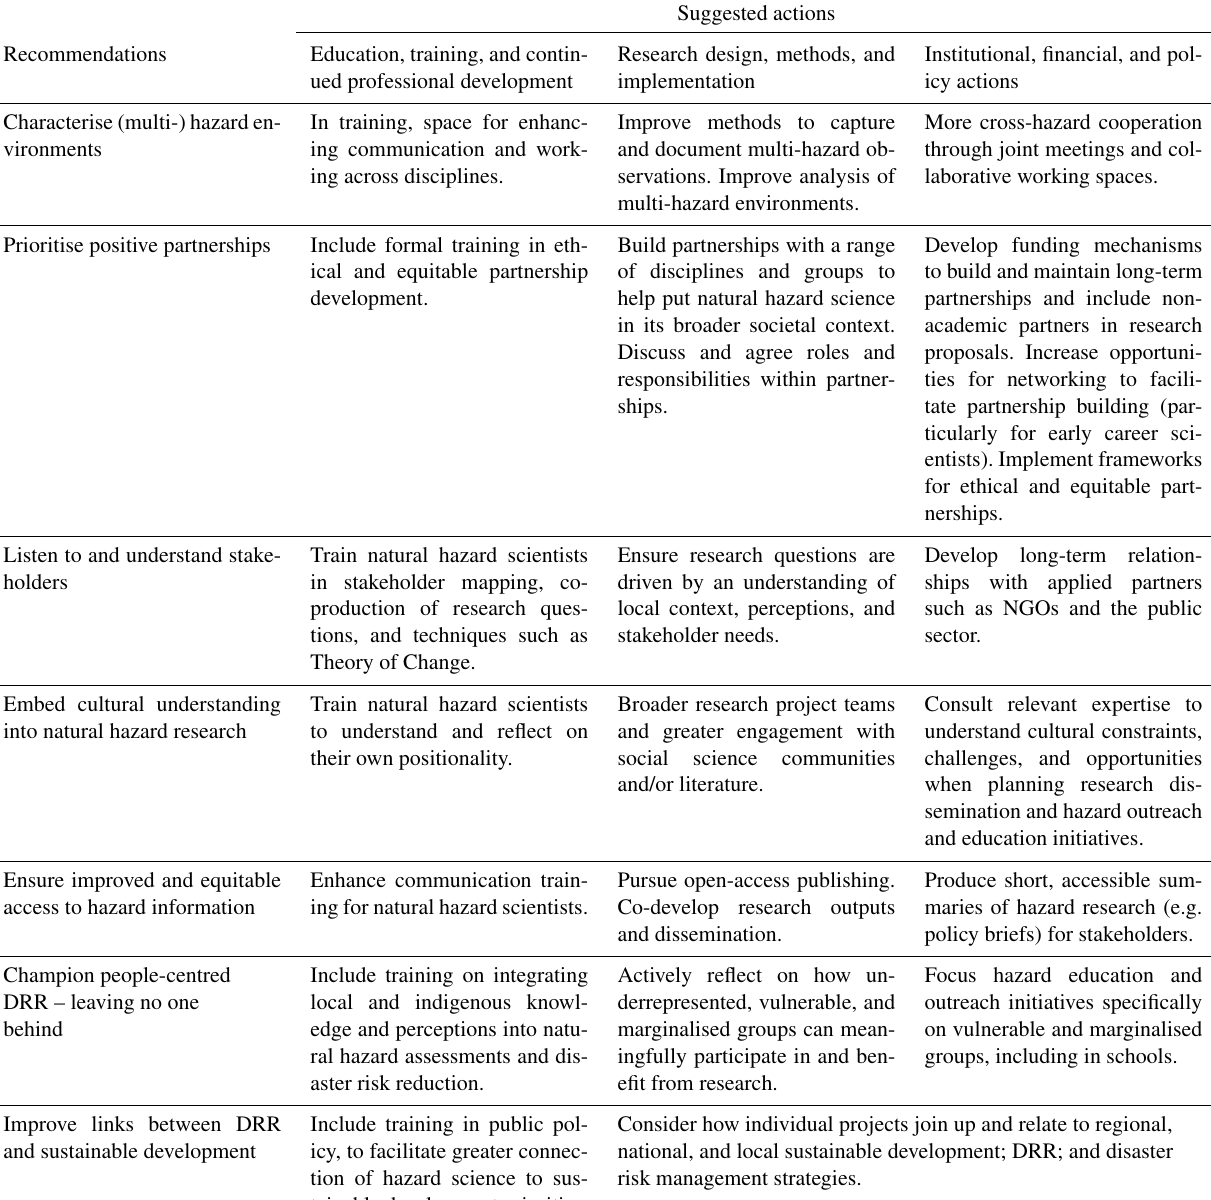
Table 3. Summary of action points to help improve engagement of natural hazard scientists in